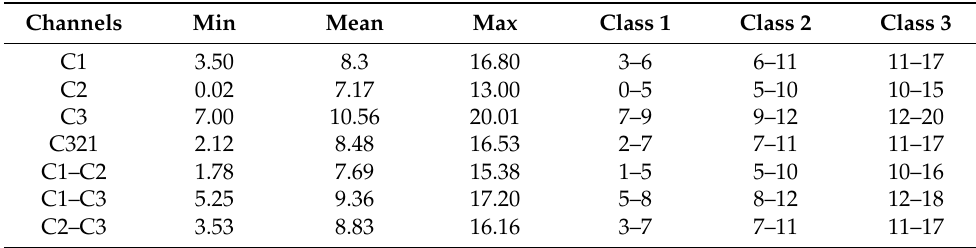
Table 3. Tree views mean scan angle statistics in each channel and corresponding scan angle class boundaries used in the balanced RF classification (all values are